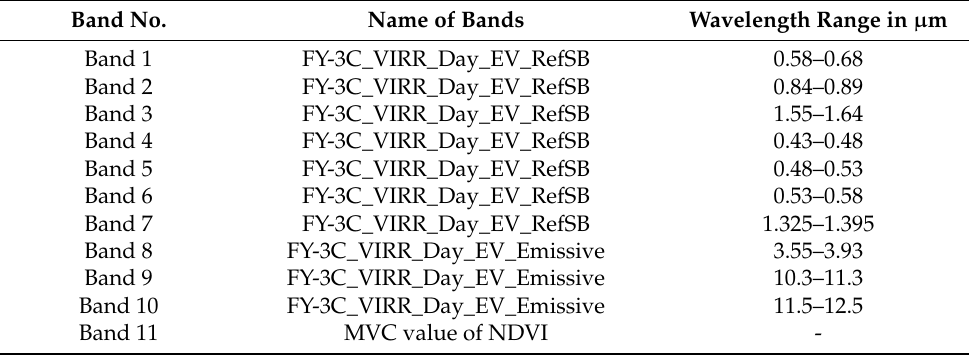
Table 2. Selected scenes/bands and their respective wavelength. Band